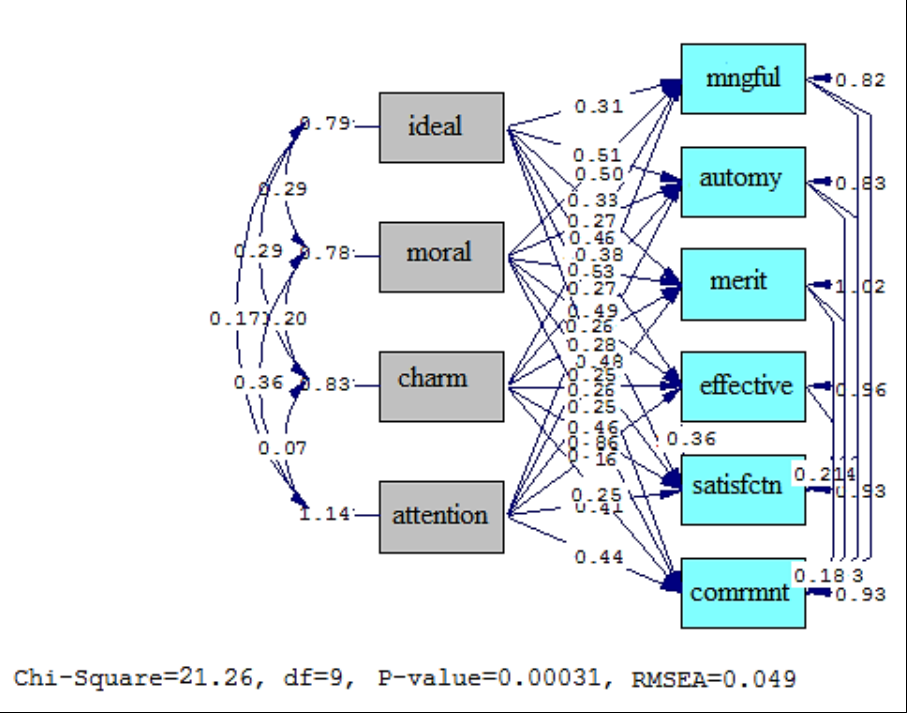
Figure 2. The main model of research in estimation of standard coefficients mode.